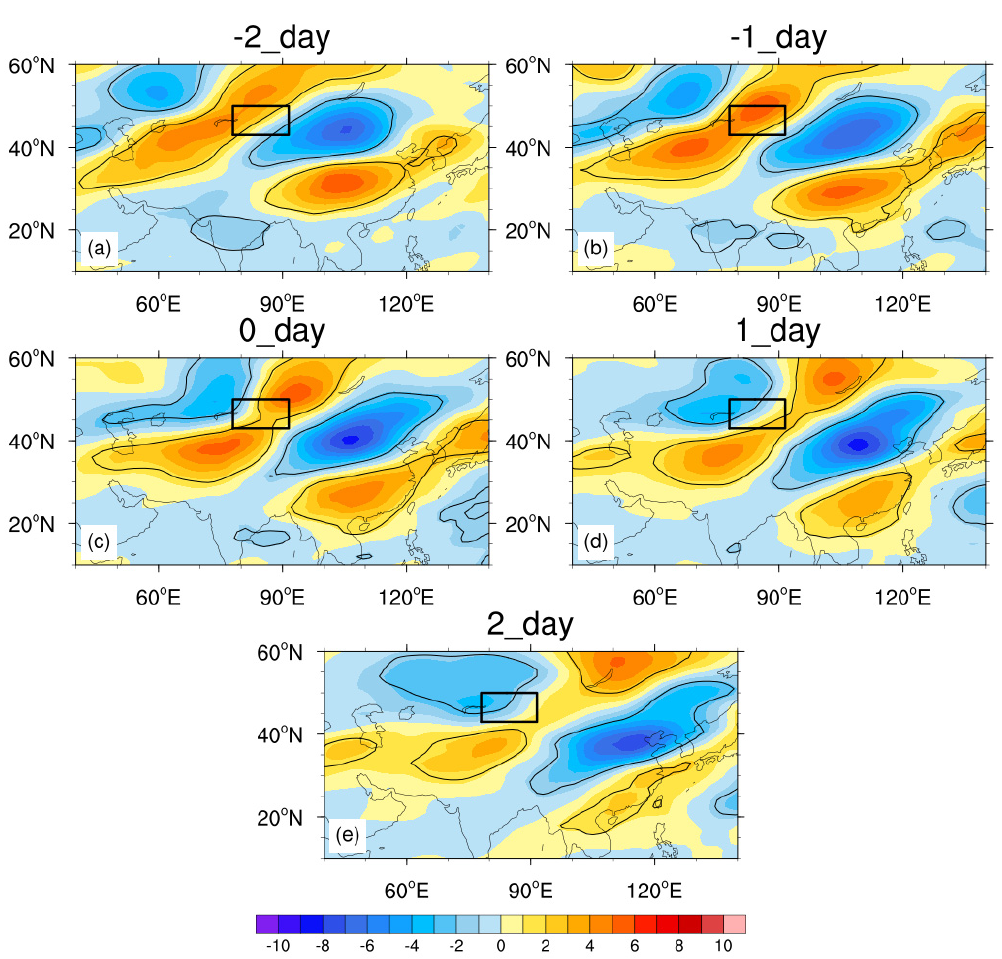
Figure 8. Composition of U200 anomaly of Type WT on the extreme precipitation day and the two days before and after ( a – e ) in the summers of 1979–2018 (Unit: m/s). The black box represents the location of the Northern Xinjiang region, and the region over the 95% significant confidence level is circled with black lines.